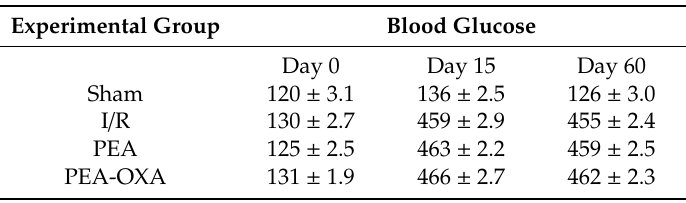
Table 1. Evaluation of glucose